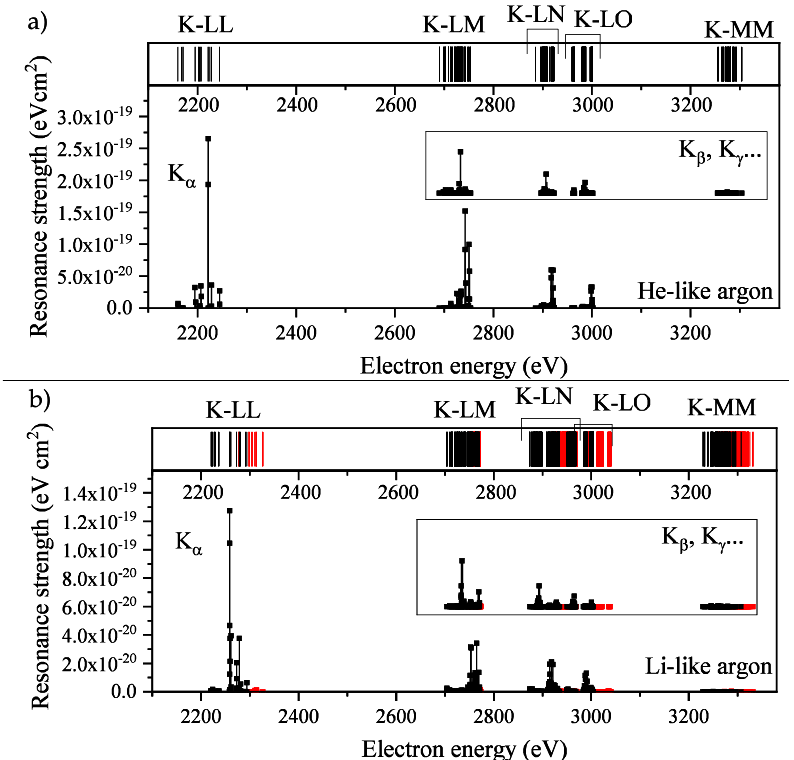
Figure 2. The results of the FAC calculation of the resonance strength (S) for resonances leading to K line emission for: ( a ) the DR processes in the He-like argon ions and ( b ) the DR (black) and TR (red) processes in the Li-like argon ions. The main graphs show the S for the K α deexcitation channel, whereas the insets present the S for the K β and K γ deexcitation channels (same scale but with